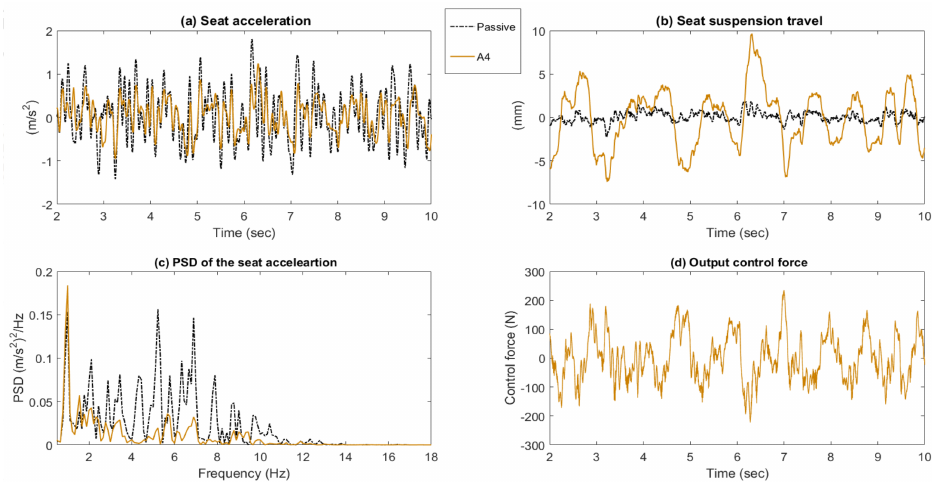
Figure 17. Time responses and PSD of the passive system and active seat suspension with controller A4.